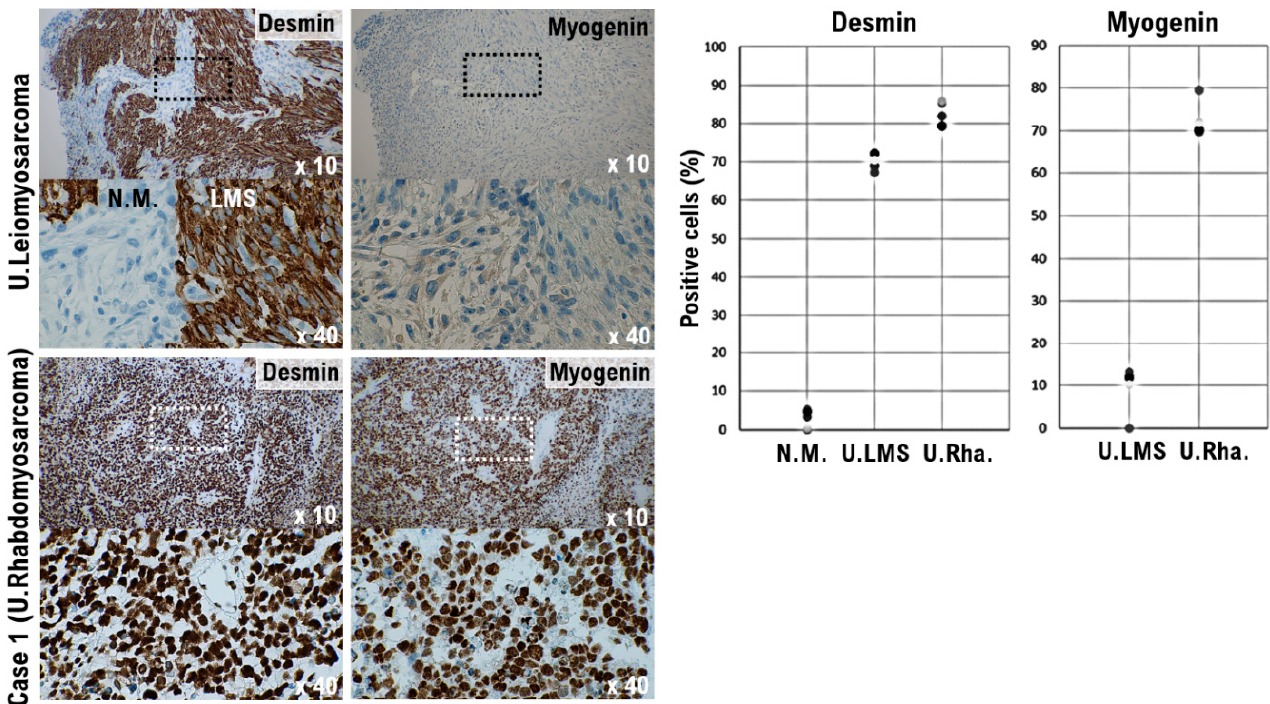
Figure 3. Significance of myogenin-positive uterine mesenchymal tumor cells in the Case 1 tumor. Differential expression of desmin and myogenin as potential biomarkers in normal myometrium, uterine leiomyosarcoma, and the Case 1 uterine tumor. The photograph shows uterine epithelioid leiomyosarcoma and normal myometrium. The low power view (10× field) shows the uterine mass irregular interface with normal myometrium, which is composed of round to polygonal cells with granular eosinophilic cytoplasm. The presence of significant nuclear atypia and mitoses is evident. A high-power view (40× field) shows tumor cells that are round to ovoid. The tumor cells have eosinophilic granular cytoplasm and irregular shaped nuclei. Immunohistochemistry (IHC) with the tissue sections of leiomyosarcoma was performed using the appropriate monoclonal antibodies (left upper panel). Case 1 uterine tumor is an admixture of round, polygonal, bizarre, or spindle cells, with marked atypia, with or without giant cells and rhabdomyoblasts. Some tumors invaded the lymphatic vessels. The low-power view (10× field) shows no obvious high grade nuclear atypia or mitotic cell proliferation. The high-power view (40× field) shows that tumor cells exhibit significant pleomorphism and some show multi-nucleated, rhabdomyoblastic differentiation. IHC with the Case 1 uterine tumor was performed using the appropriate monoclonal antibodies (left lower panel). The five tissue sites were randomly selected from normal myometrium, uterine leiomyosarcoma, and the Case 1 uterine tumor. In a 40x field of view, the positive rates for the two biomarkers were determined in three tissue sites under a microscope (Panthera Shimadzu Co. Ltd., Kyoto, Japan) (right panel). The positive rates at the sites for each tissue are shown in a scatter plot.